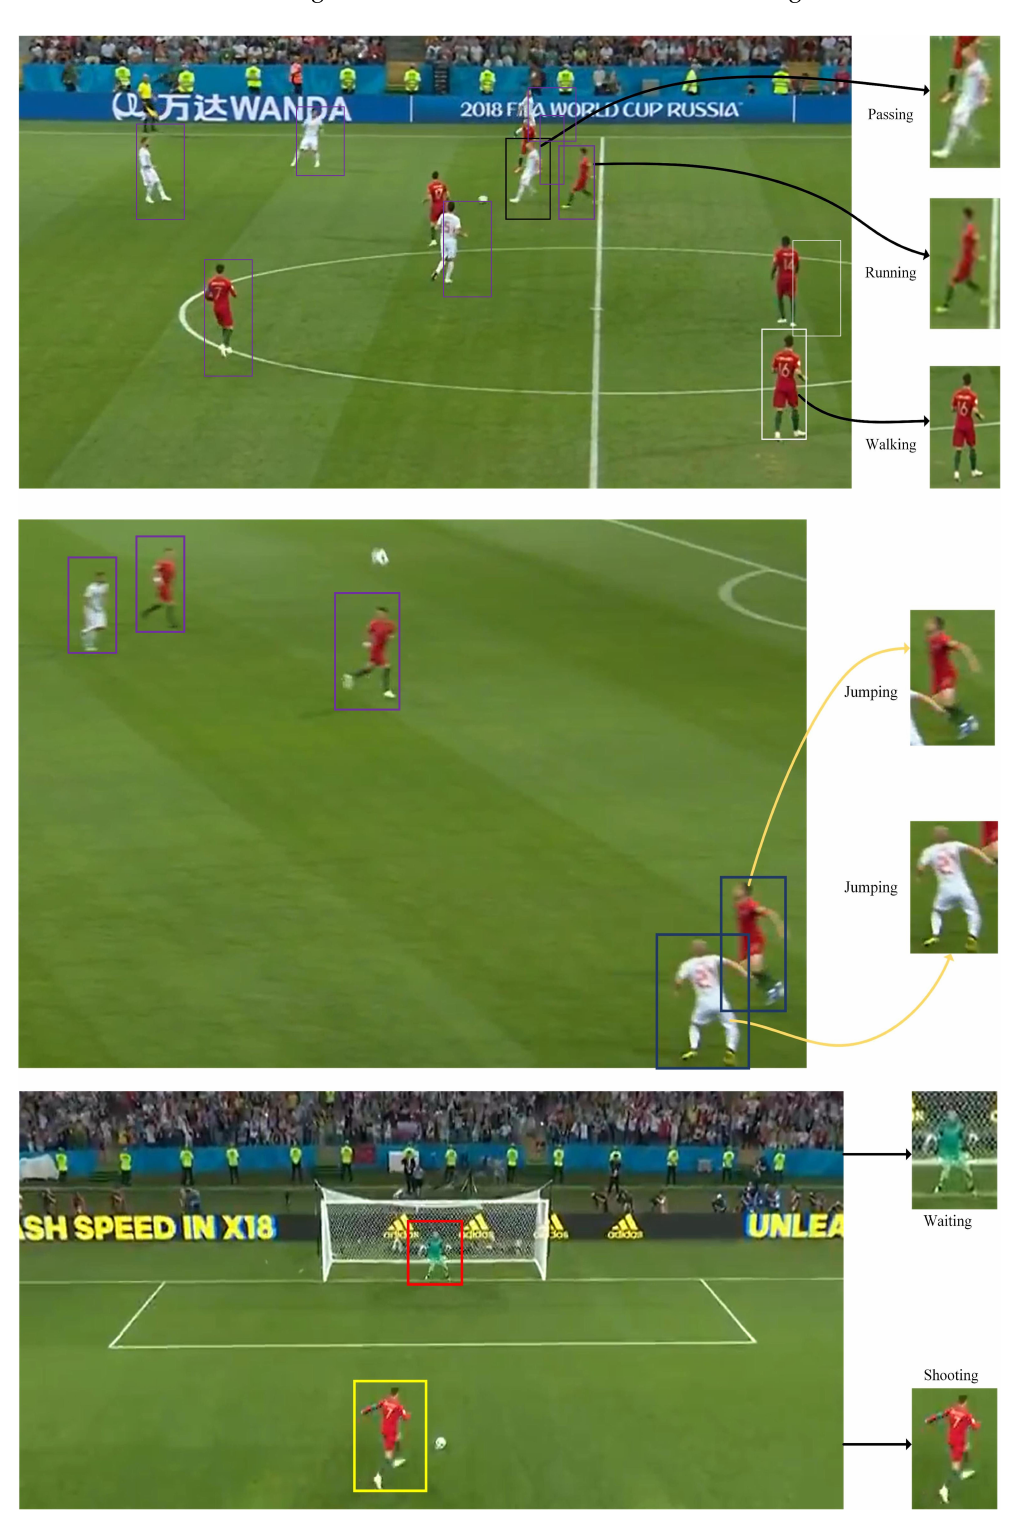
Figure 7. Qualitative results of football dataset. The color of the bounding box represents the action label (white: walking; black: passing; purple: running; blue: jumping; red: waiting; yellow: